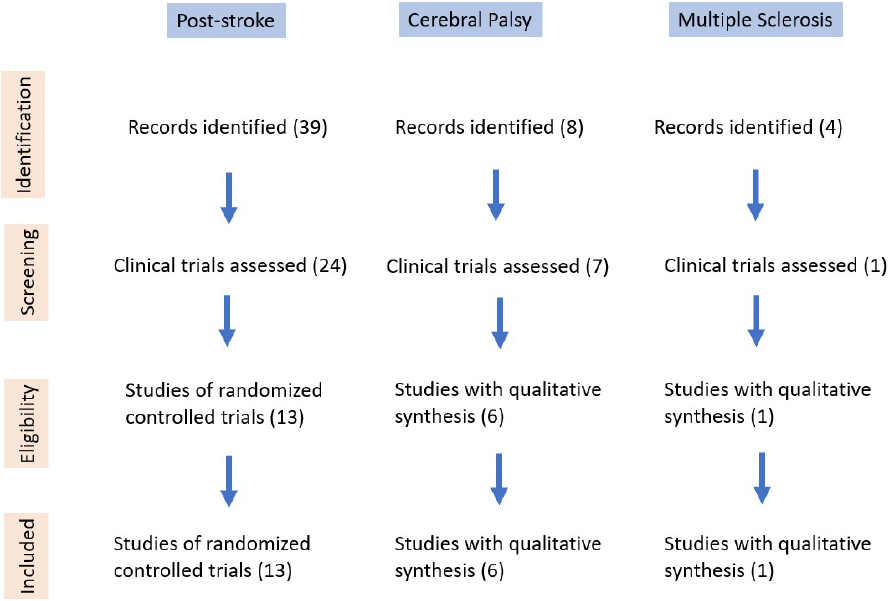
Figure 1. Diagram of selection process and identification of eligible studies.